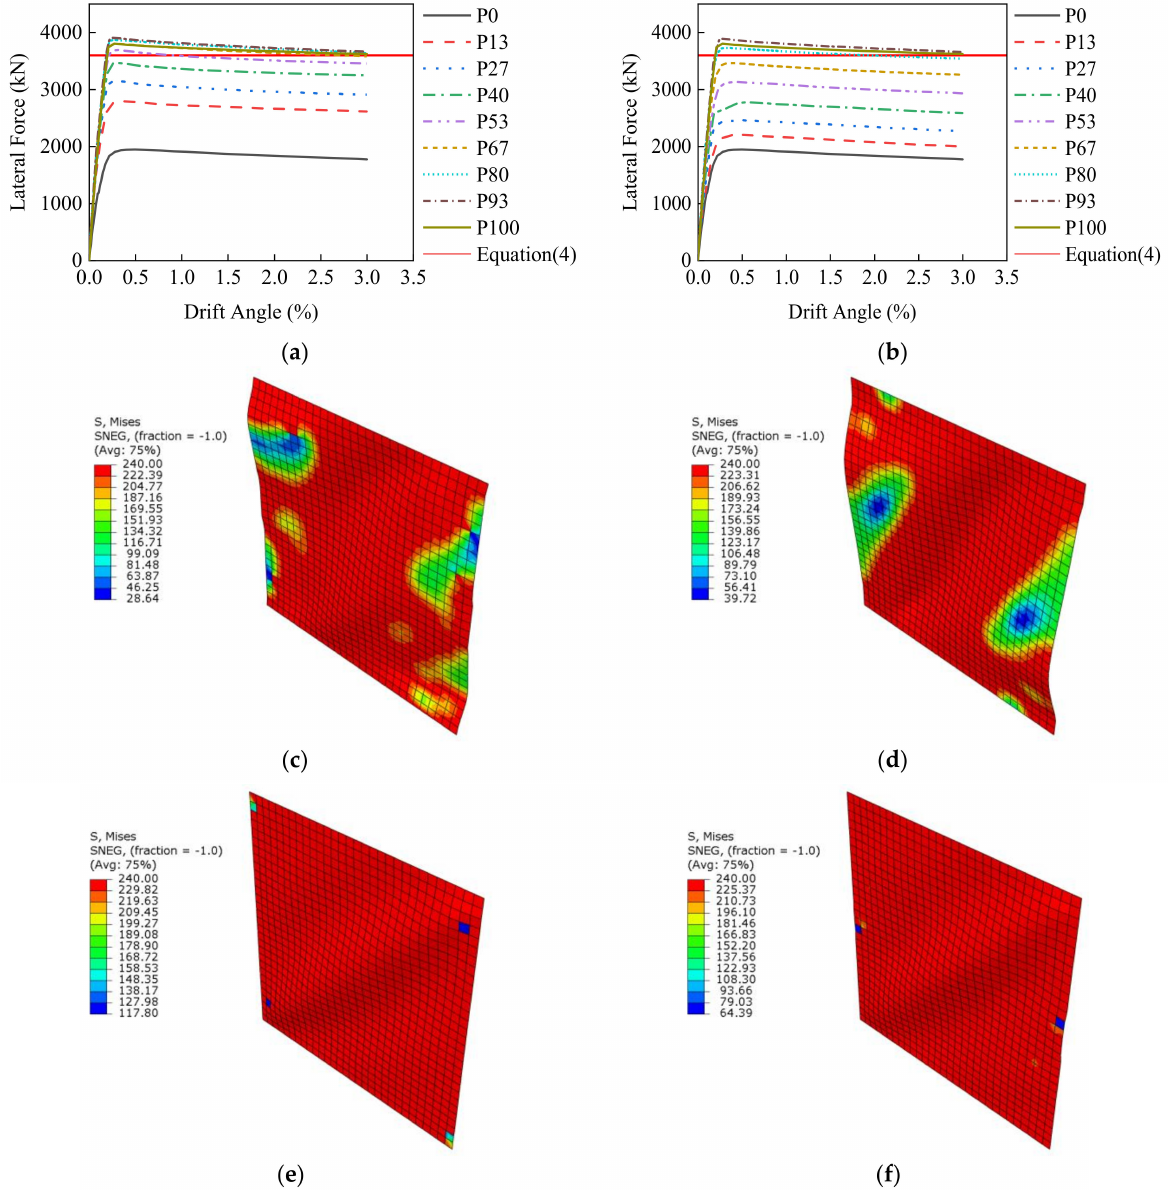
Figure 8. Load-displacement curves and stress distributions at 3% drift of S1 and S1R models: ( a ) S1; ( b ) S1R; ( c ) S1-P13; ( d ) S1R-P13; ( e ) S1-P80; ( f )